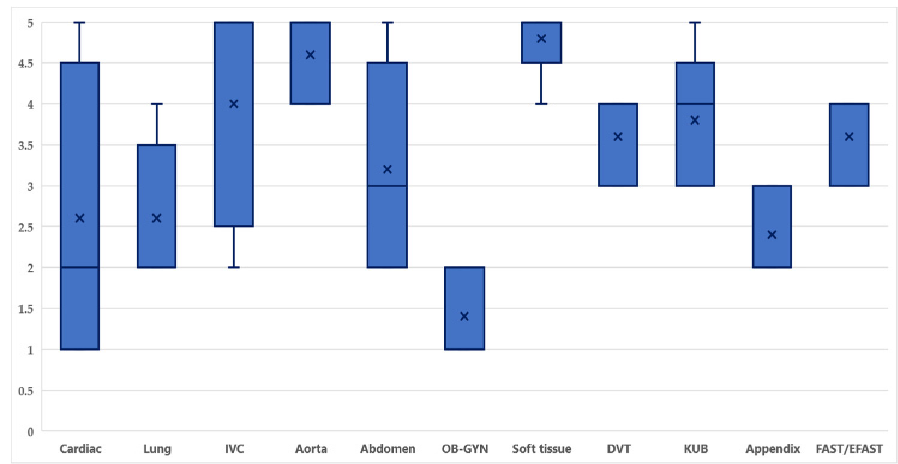
Figure 1. Image quality score divided by area of POCUS examination. Abbreviation: inferior vena cava (IVC), obstetrics and gynecology (OB-GYN), deep venous thrombosis (DVT), kidney and urinary bladder (KUB), and focused assessment with sonography for trauma (FAST) scan/extended FAST (EFAST).